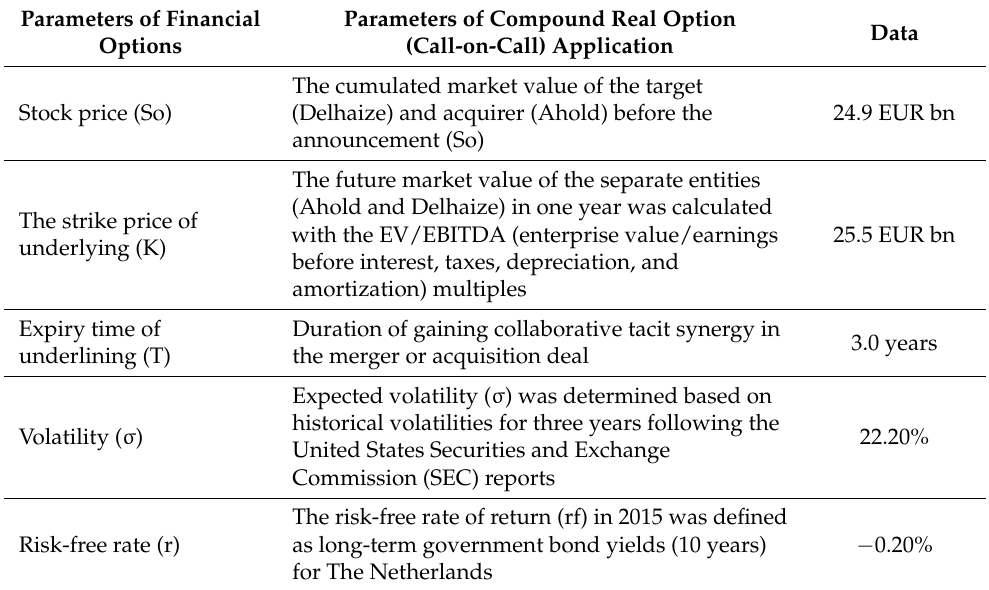
Table 4. The valuation of tacit synergies of the Ahold Delhaize group with the Black–Scholes option pricing model (in the period of 2016–2018).